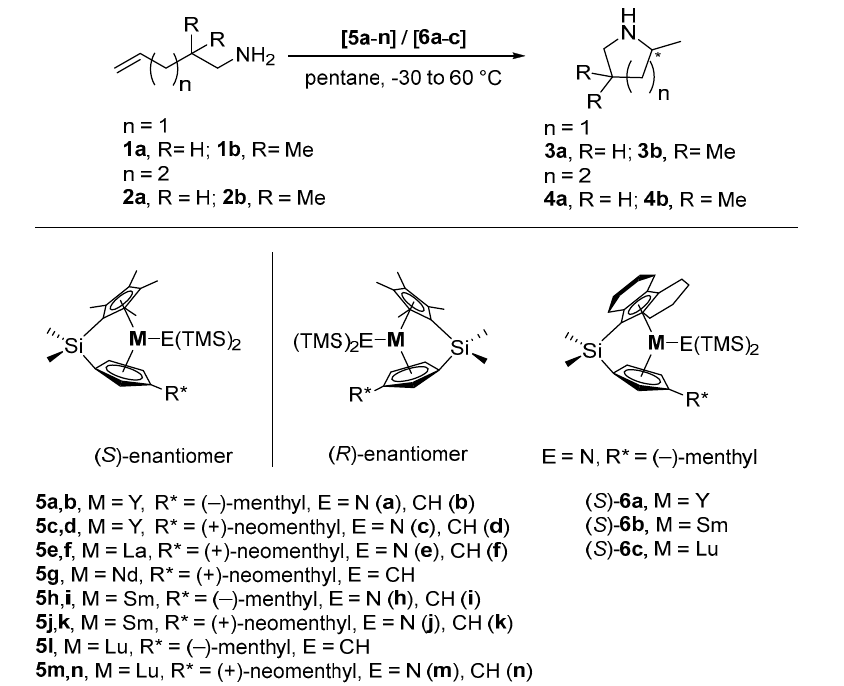
Scheme 1. Catalytic asymmetric hydroamination of aminoalkenes 1a , b and 2a , b using chiral lan- thanocene complexes ( S )/( R )- 5a – n and ( S )- 6a – c [54,60,73]. (For more details concerning catalysis data see Table 1). Table 1. Catalytic asymmetric hydroamination reactions of 1a , b and 2a , b using chiral rare earth metal complexes ( S )/( R )- 5a – n and ( S )- 6a – c . Entry Cat.